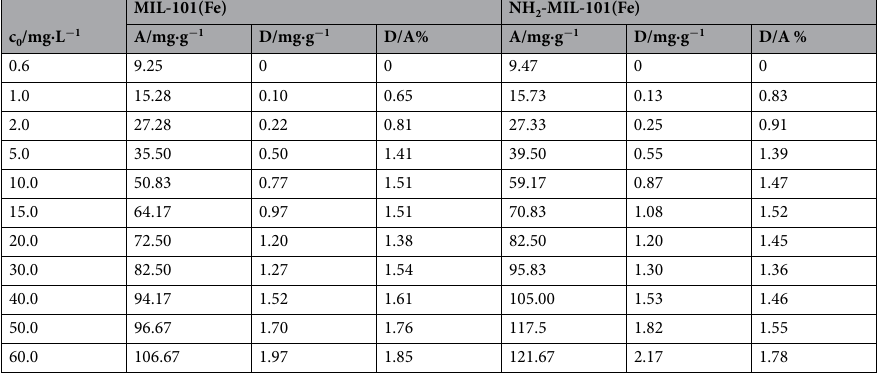
Table 2. The ratio of desorbed P to adsorbed P for Fe-based MIL MOFs. A-Adsorbed phosphate(mg·g − 1